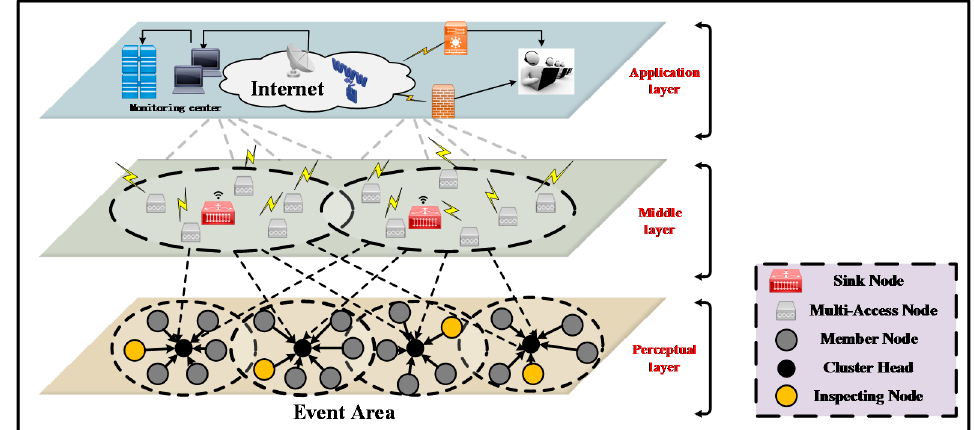
Figure 4. The network model establishment of GIN protocol.